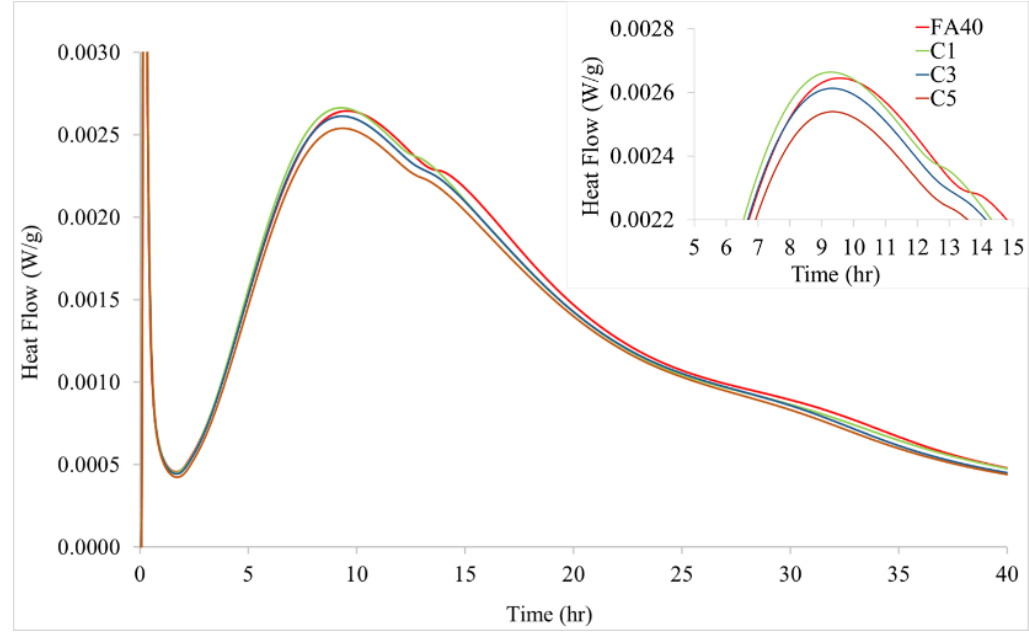
Figure 5. Effect of amount of commercial α-Fe 2 O 3 at 0.0%, 1.0%, 3.0% and 5.0% on the time dependent heat of hydration for fly ash (FA) blended cement. Inset: Enlarged image for heat flow during stages 3 and 4 to show peak maxima for samples C1-C3 and control FA40.